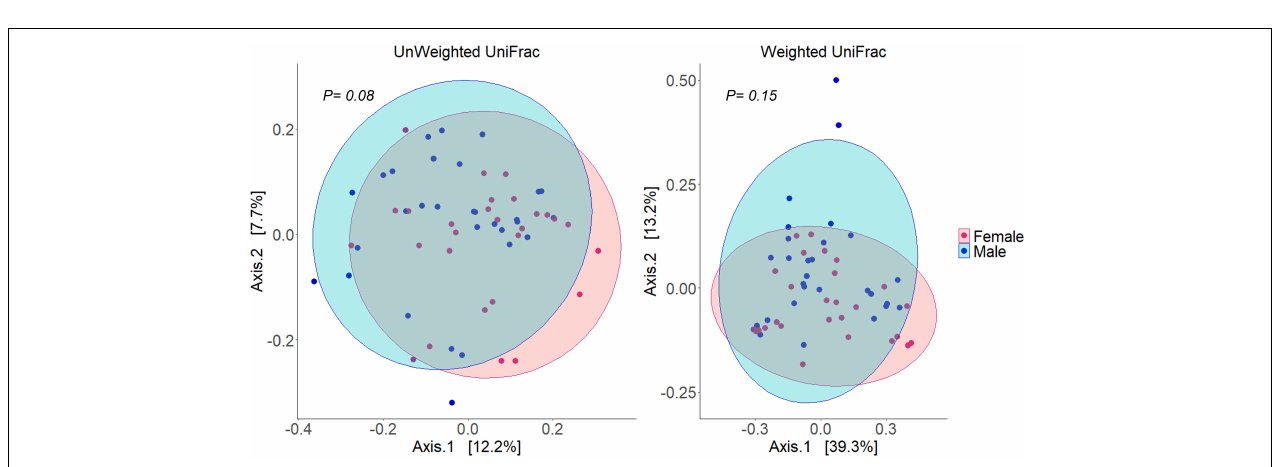
FIGURE 3 | Principal coordinates analyses (PCoA) using distance (Unweighted and weighted UniFrac) matrices of the bacteria in the buccal cavity of female and male Nile tilapia. The ellipses were generated assuming that the data are from a multivariate normal distribution.